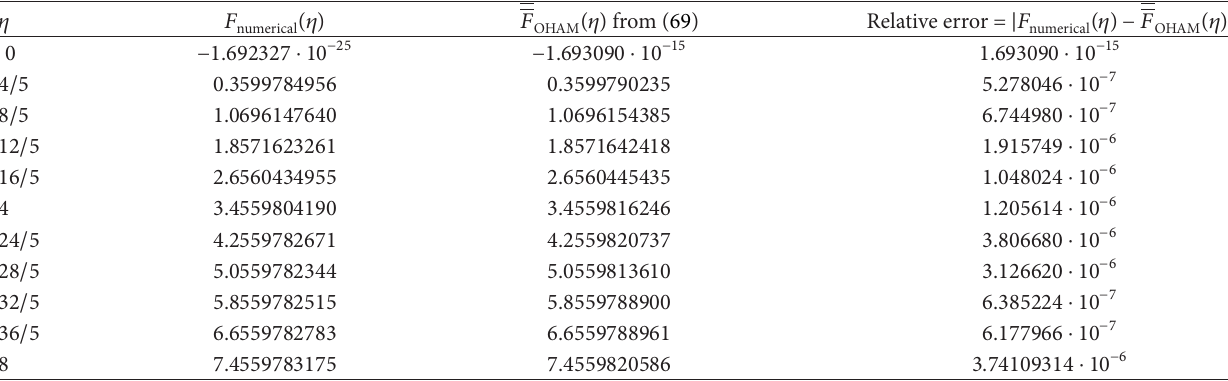
Table 23: Comparison between OHAM results given by (69) and numerical solutions for 𝛽 = 1.6 .